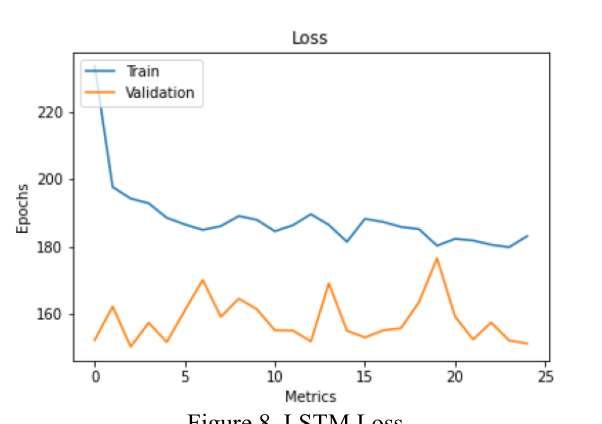
Figure 8. LSTM Loss The forecasting of the open price of TATASTEEL using LSTM models shows that its results are better than CNN but lags behind.